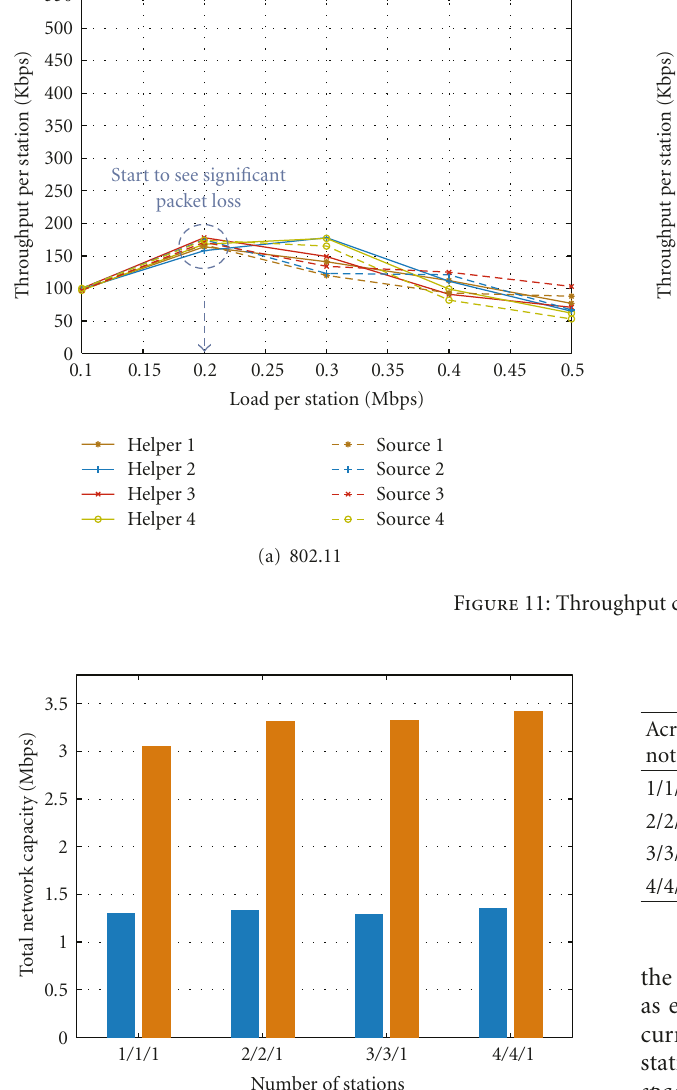
Figure 12: Network capacity versus number of stations.